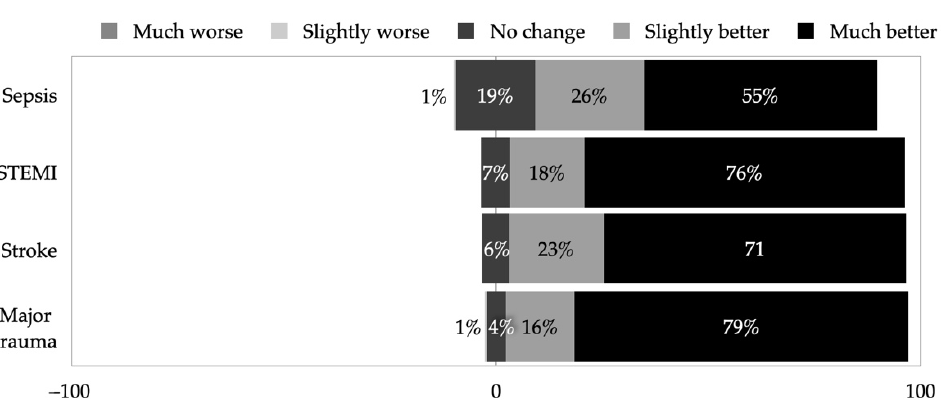
Figure 3. EMS staff evaluated the change of prehospital care quality over their